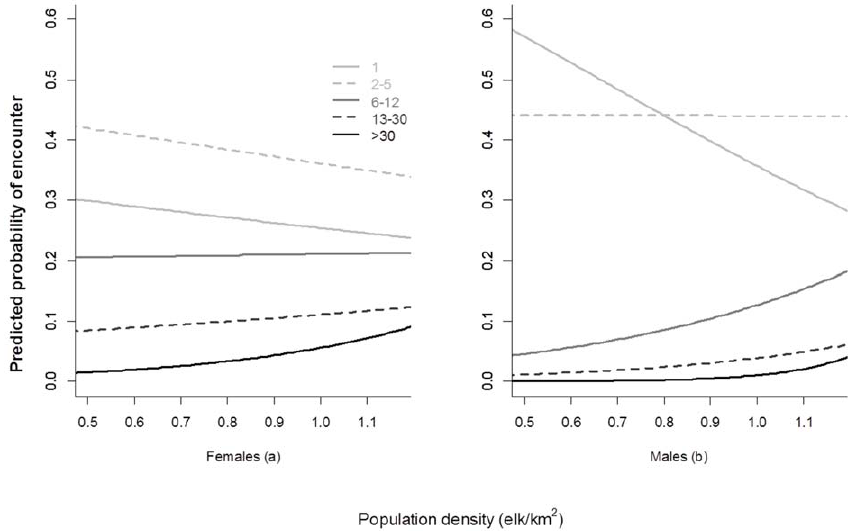
Figure 3. Predicted probability of encounter rate of groups ( binned by size ) for female ( a ) and male ( b ) elk with changes in population density in Riding Mountain National Park ( 2002–2005 and 2007–2009 )